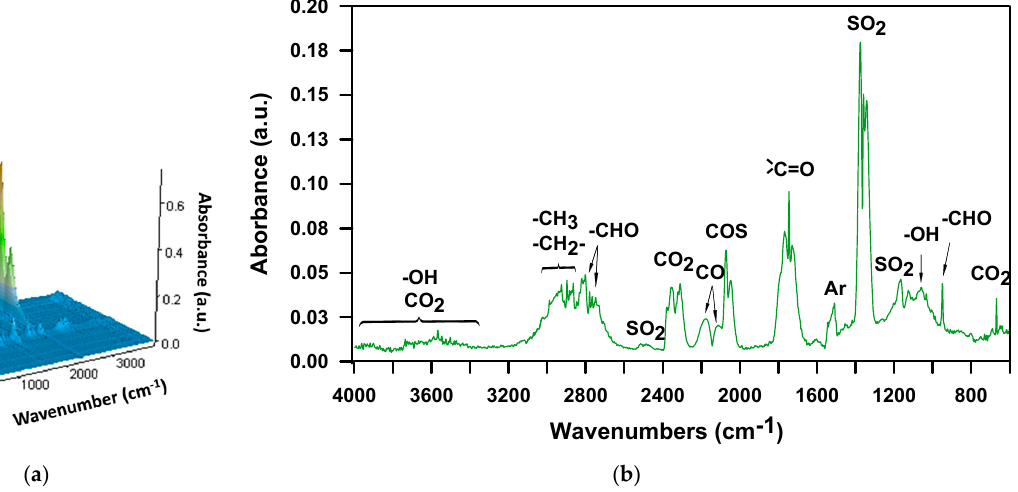
Figure 6. FTIR spectra of volatile products evolved during thermal decomposition of M-100 in air: ( a ) 3D and ( b ) extracted at the maxima of decomposition, ( c ) carbonyl sulfide and sulfur dioxide release for M-100 during TG-FTIR analysis in air.